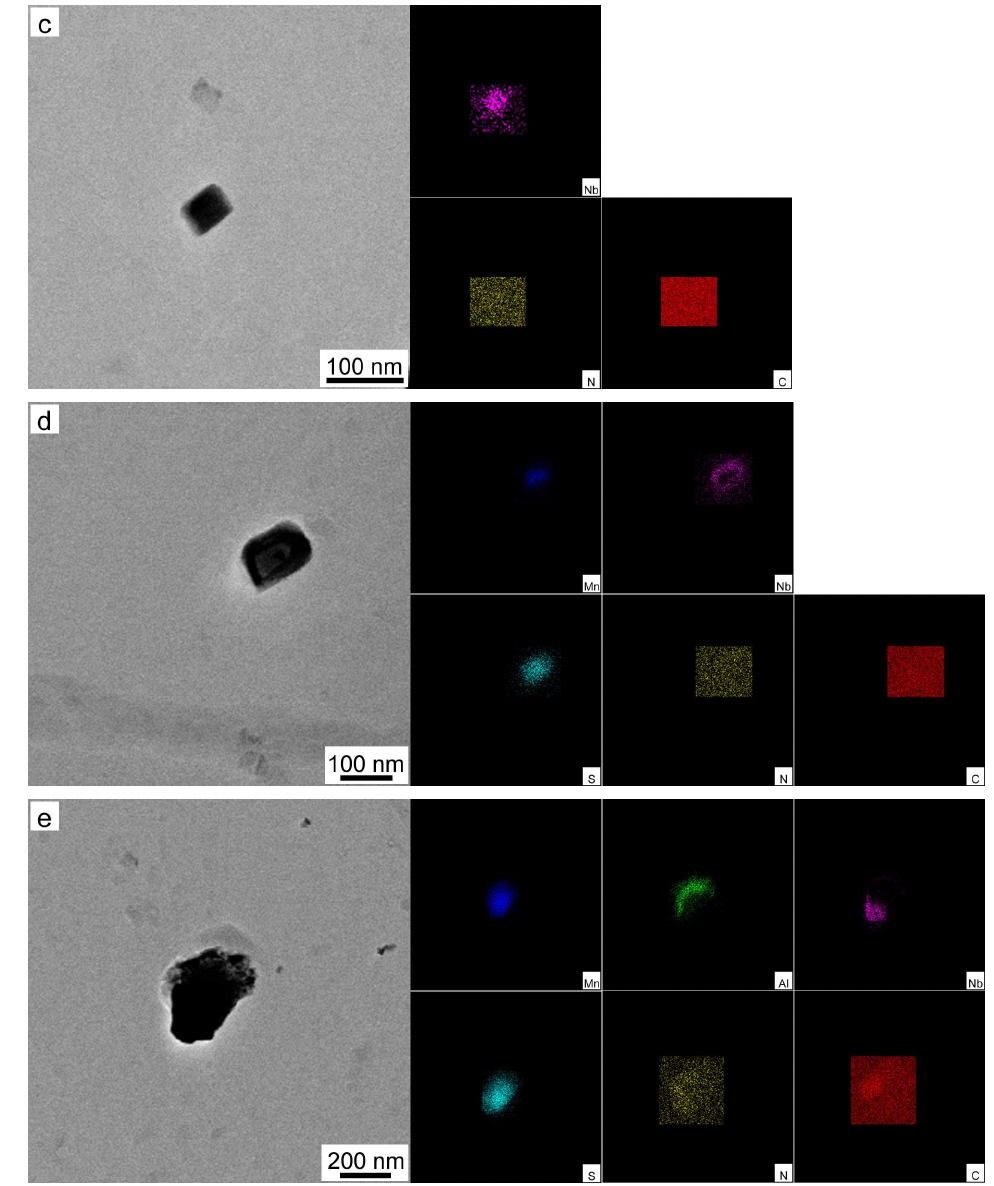
Figure 1. Precipitate morphologies observed by TEM and EDS elemental mapping of precipitates: